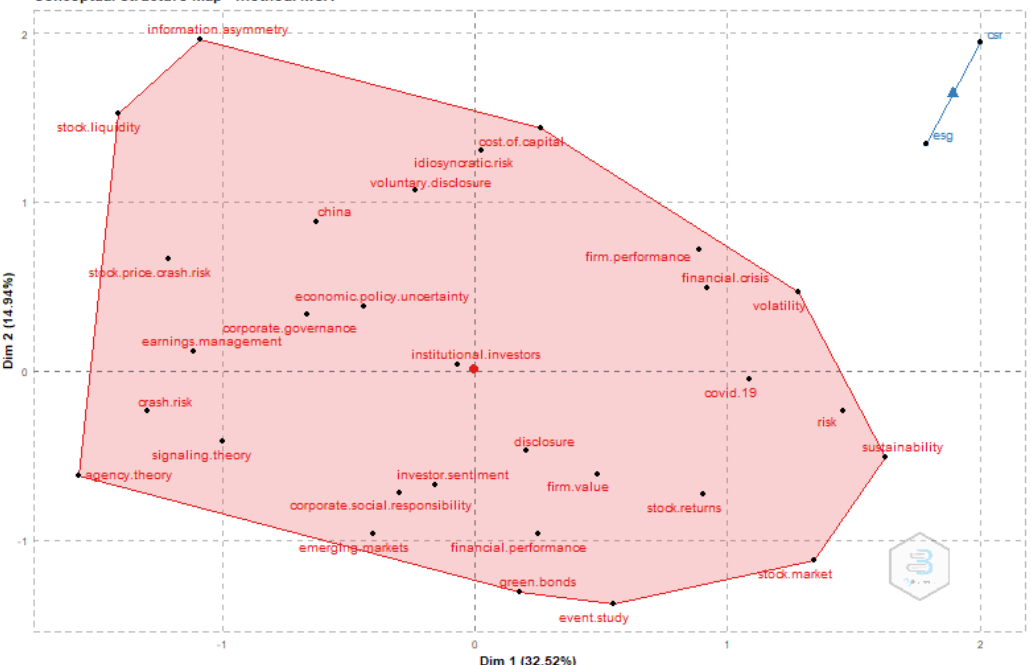
Figure 9. Factorial analysis based on the MCA method. Source: Scopus/Biblioshiny. The cluster in red color highlights the importance of CSR in the mitigation of any type of volatility such as asymmetric information and stock price crash risk [31]. On the other side, the cluster in blue color highlights the need for a model that will be based